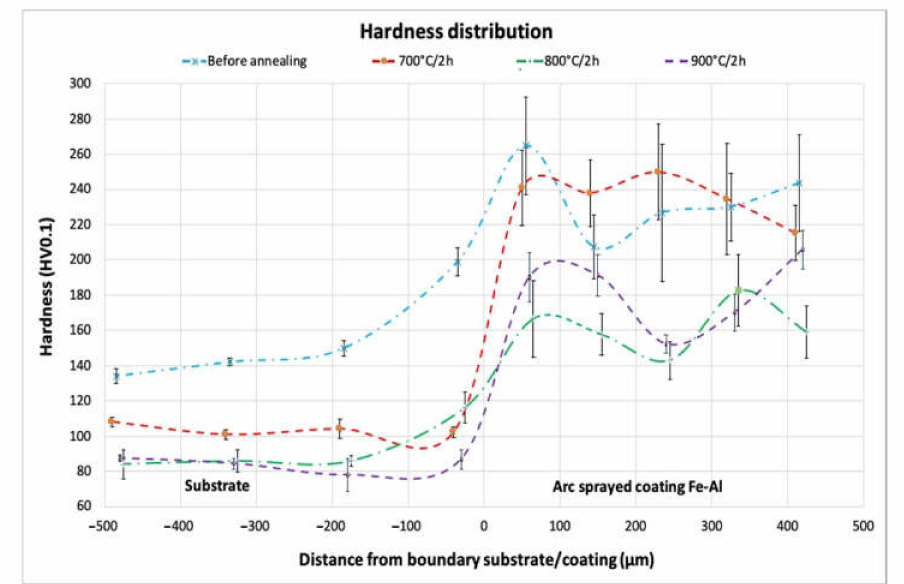
Figure 13. Distribution of microhardness in the cross-section of the substrate material and the arc-sprayed Fe-Al coating, before and after annealing at temperatures 700 ◦ C, 800 ◦ C, and 900 ◦ C.